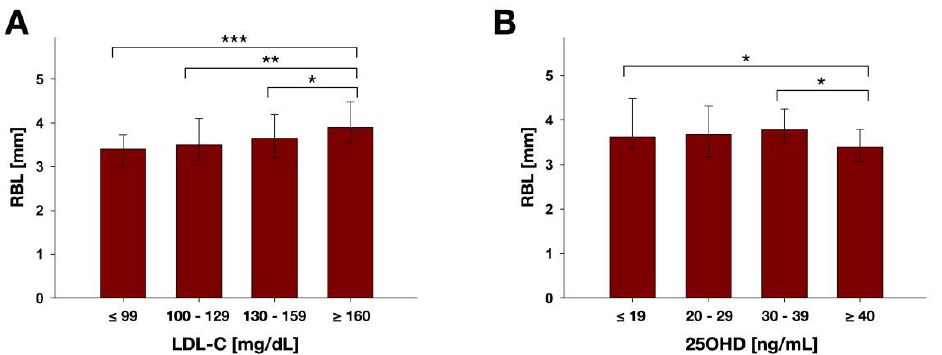
Figure 5. Results of RBL analysis according to the different ( A ) LDL-C groups ( ≤ 99, n = 30; 100–129, n = 51; 130–159, n = 41; ≥ 160, n = 36) and ( B ) 25OHD groups ( ≤ 19, n = 38; 20–29, n = 38; 30–39, n = 21; ≥ 40, n = 20). Results are depicted as medians, first and third quartiles and asterisks depict statistically significant differences between the groups. * marks significant differences with p ≤ 0.05; ** marks significant differences with p ≤ 0.01; *** marks significant differences with p ≤ 0.001.